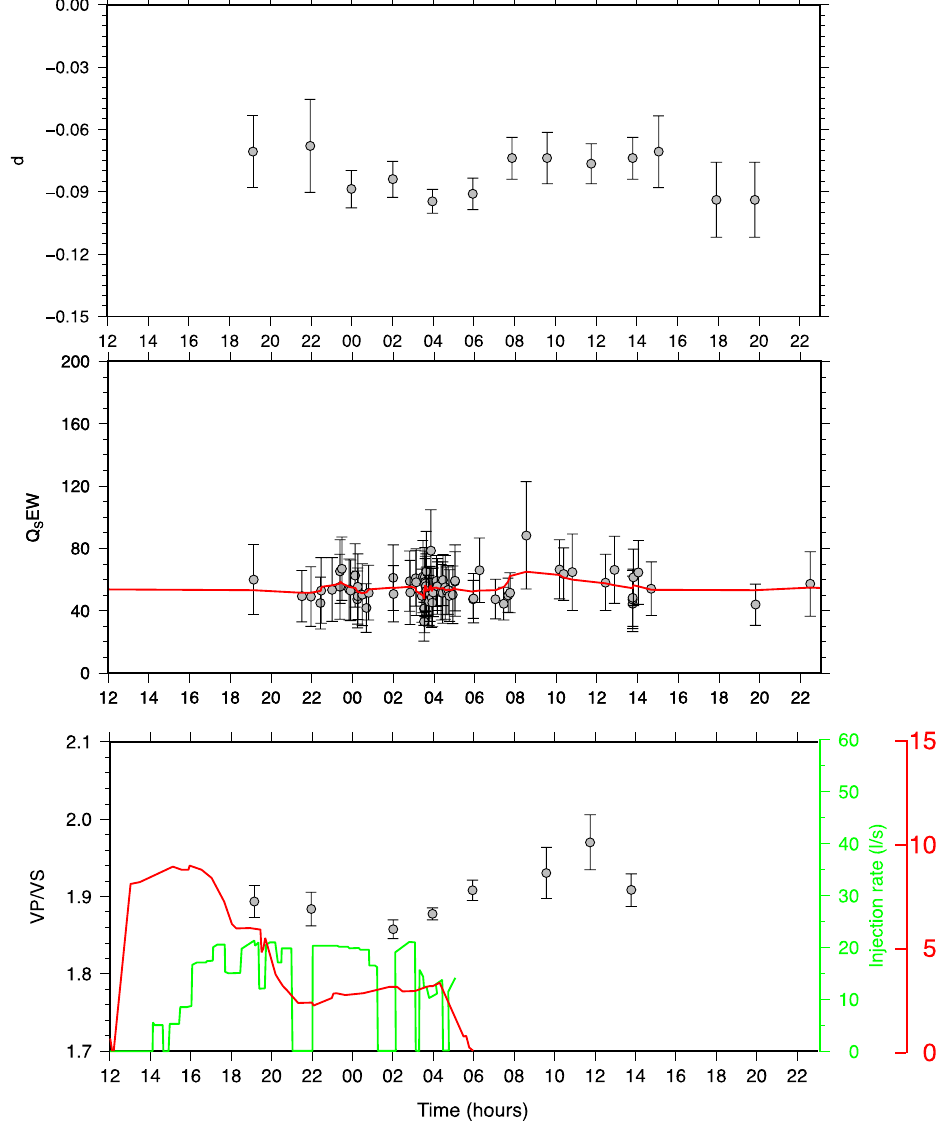
Figure 9. Same as Fig. 5 but for St. Gallen geothermal field relative to the time period 2013/07/19 12:00:00 up to 2013/07/20